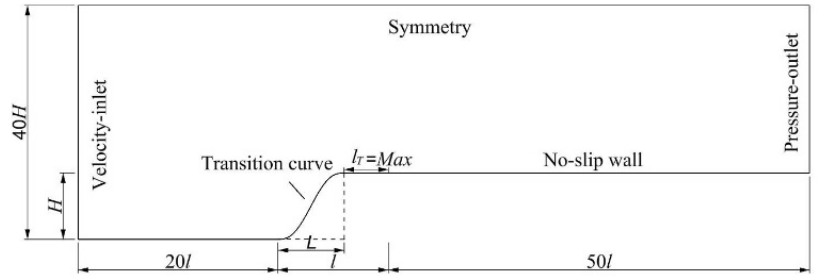
Figure 6. Computational domain and boundary conditions.